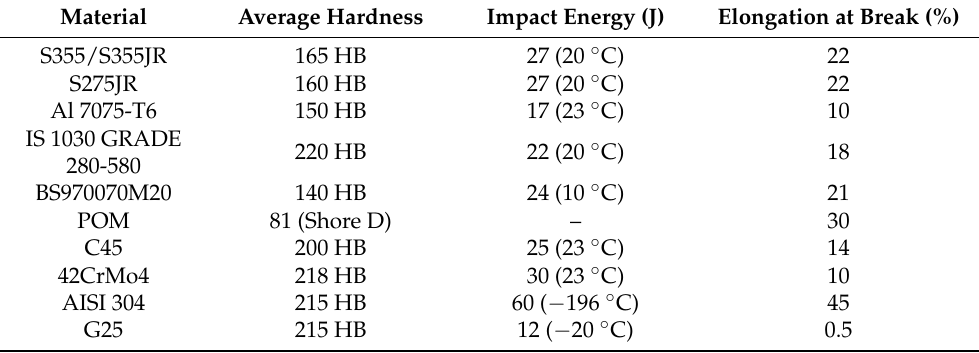
Table 8. Additional properties of the materials used for bottoms and